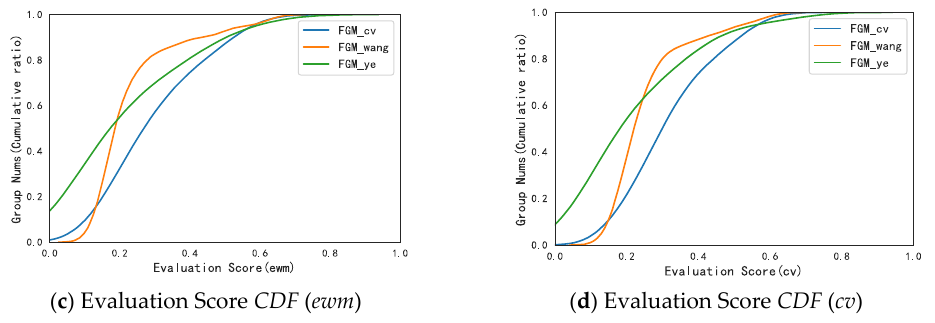
Figure 8. Compared with Baselines.